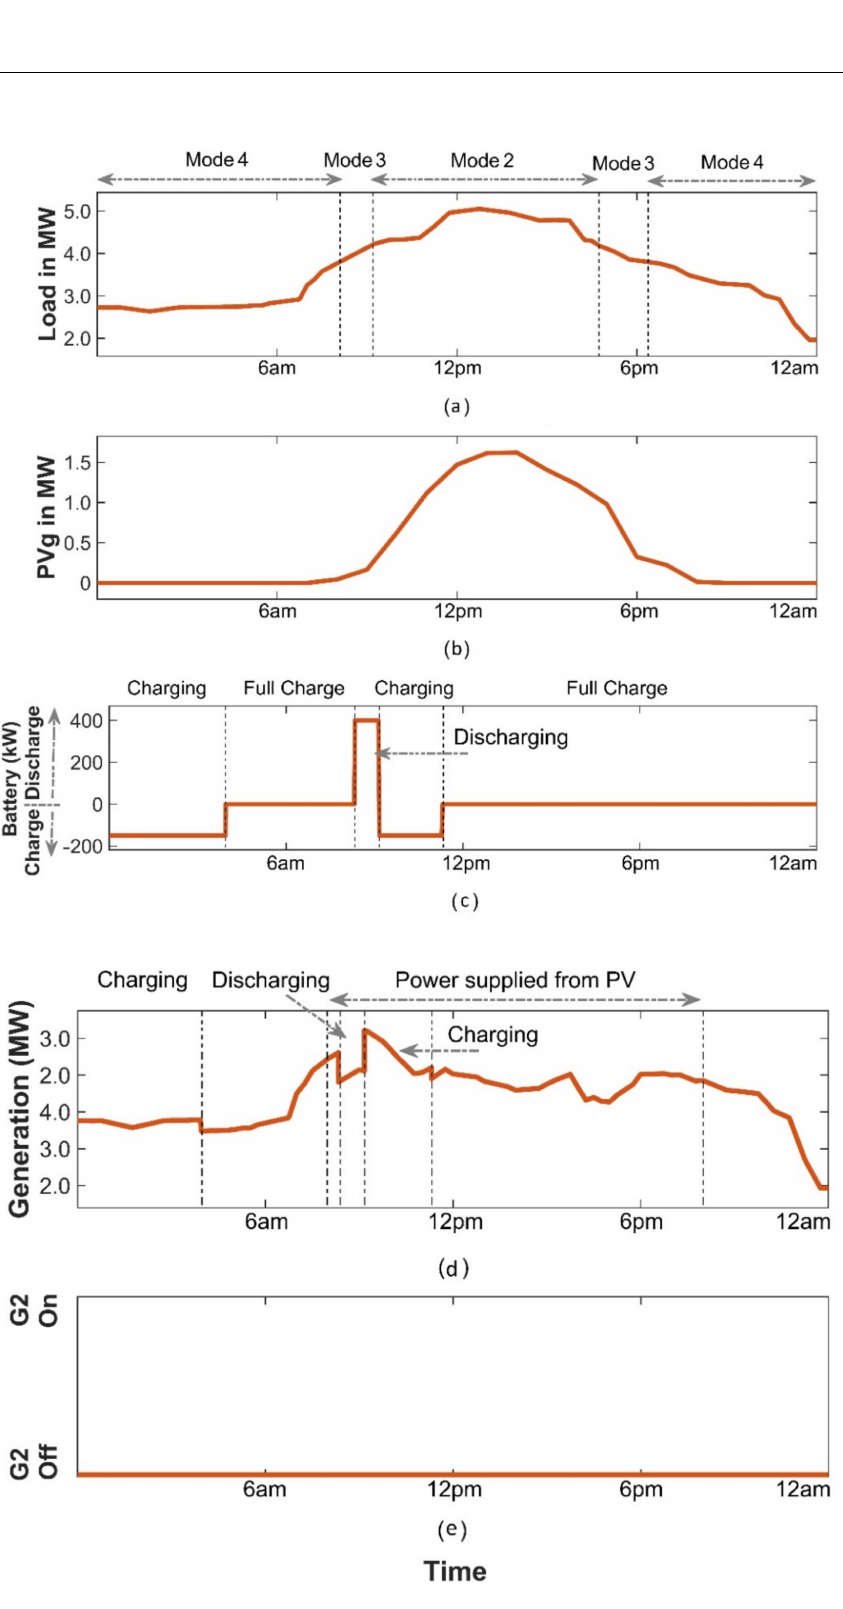
Figure 7. ( a ) Variable load profile (semester break), ( b ) PV generation (average value), ( c ) BESS charging-discharging operation, ( d ) Operation of peak load shaving, and ( e ) Operation of economic generation